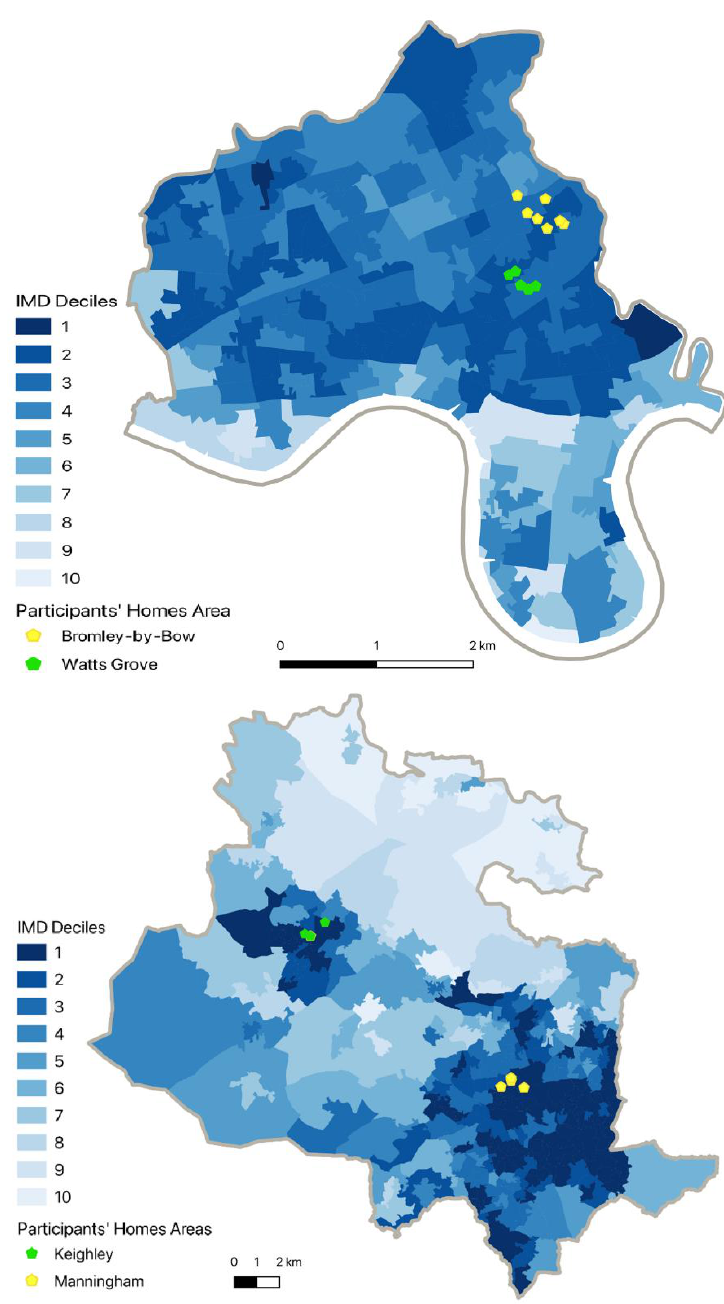
Figure 1. Location of interviewees’ homes within each local authority and IMD deciles (Tower Ham- lets, top; Bradford, bottom).